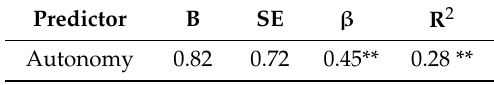
Table 1. E ff ect of satisfaction of need for autonomy on work